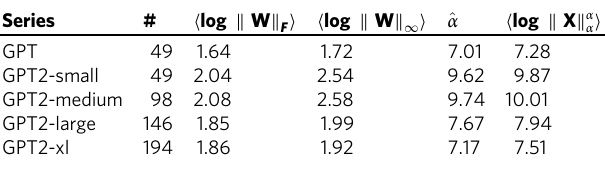
Column # refers to number of layers treated. Averages do not include the fi rst embedding layer (s)because theyare not (implicitly) normalized. GPThas 12 layers, with 4 Multi-headAttention Blocks, giving 48 layer Weight Matrices, W . Each Block has 2 components, the Self Attention (attn) and the Projection (proj) matrices. Self-attention matrices are larger, of dimension (2304×768) or (3072×768). The projection layer concatenates the self-attention results into a vector (of dimension 768). This gives 50 large matrices. Because GPT and GPT2 are trained on different data sets, the initial Embedding matrices differ in shape. GPT has an initial Token and Positional Embedding layers, of dimension (40478×768) and (512×768), respectively, whereas GPT2 has input Embeddings of shape (50257×768) and (1024×768), respectively. The OpenAI GPT2 (English) models are: GPT2-small, GPT2-medium, GPT2-large, and GPT2-xl, having 12, 24, 36, and 48 layers, respectively, with increasingly larger weight